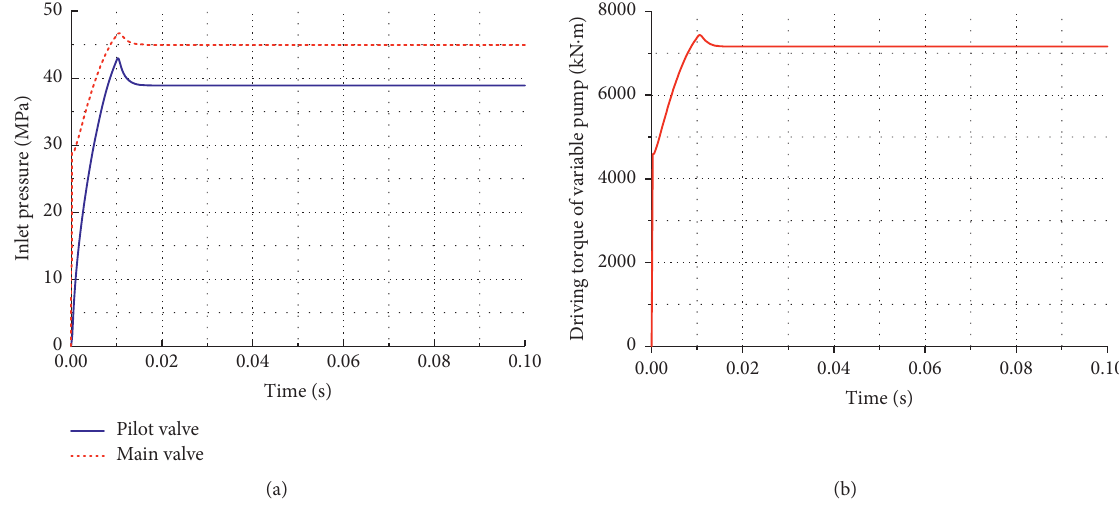
Figure 7: Dynamic characteristic curves. (a) Inlet pressure of relief valve. (b) Driving torque of variable